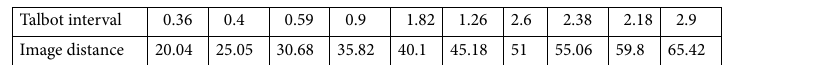
Table 1. Relation between the interval of adjacent images and the imaging distance in the LRTM image process.